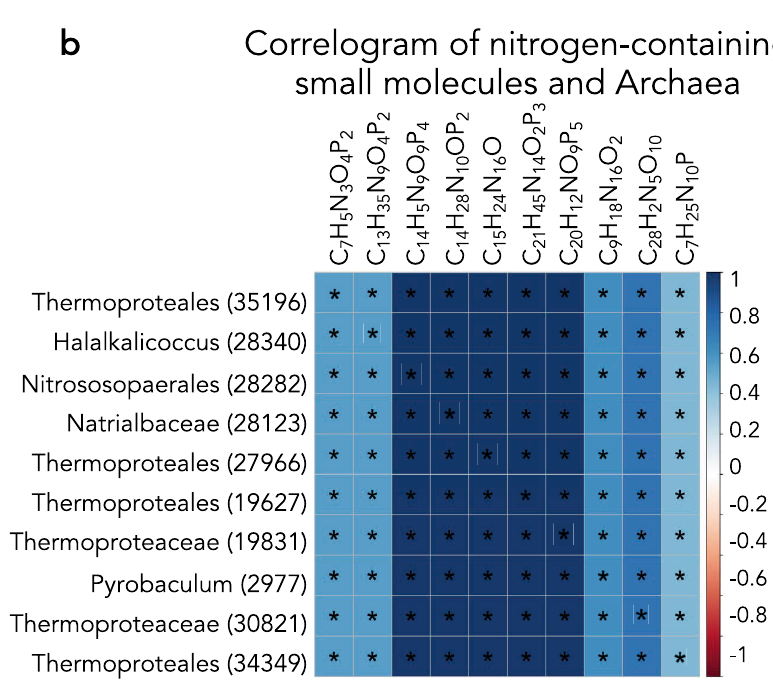
Figure 7. Data from all available datasets were examined to determine correlative features. ( a ) Correlogram as described in the methods section investigating archaeal ZOTUs and sulfur containing extracellular small molecules. ( b ) Correlogram of archaeal ZOTUs and nitrogen containing extracellular small molecules. The intensity of the color indicates the strength of the correlation, with blue demonstrating positive and red demonstrating negative correlations. An asterisk indicates a p-value of < 0.05 for the correlation. Correlograms were created using the mixOmics package in